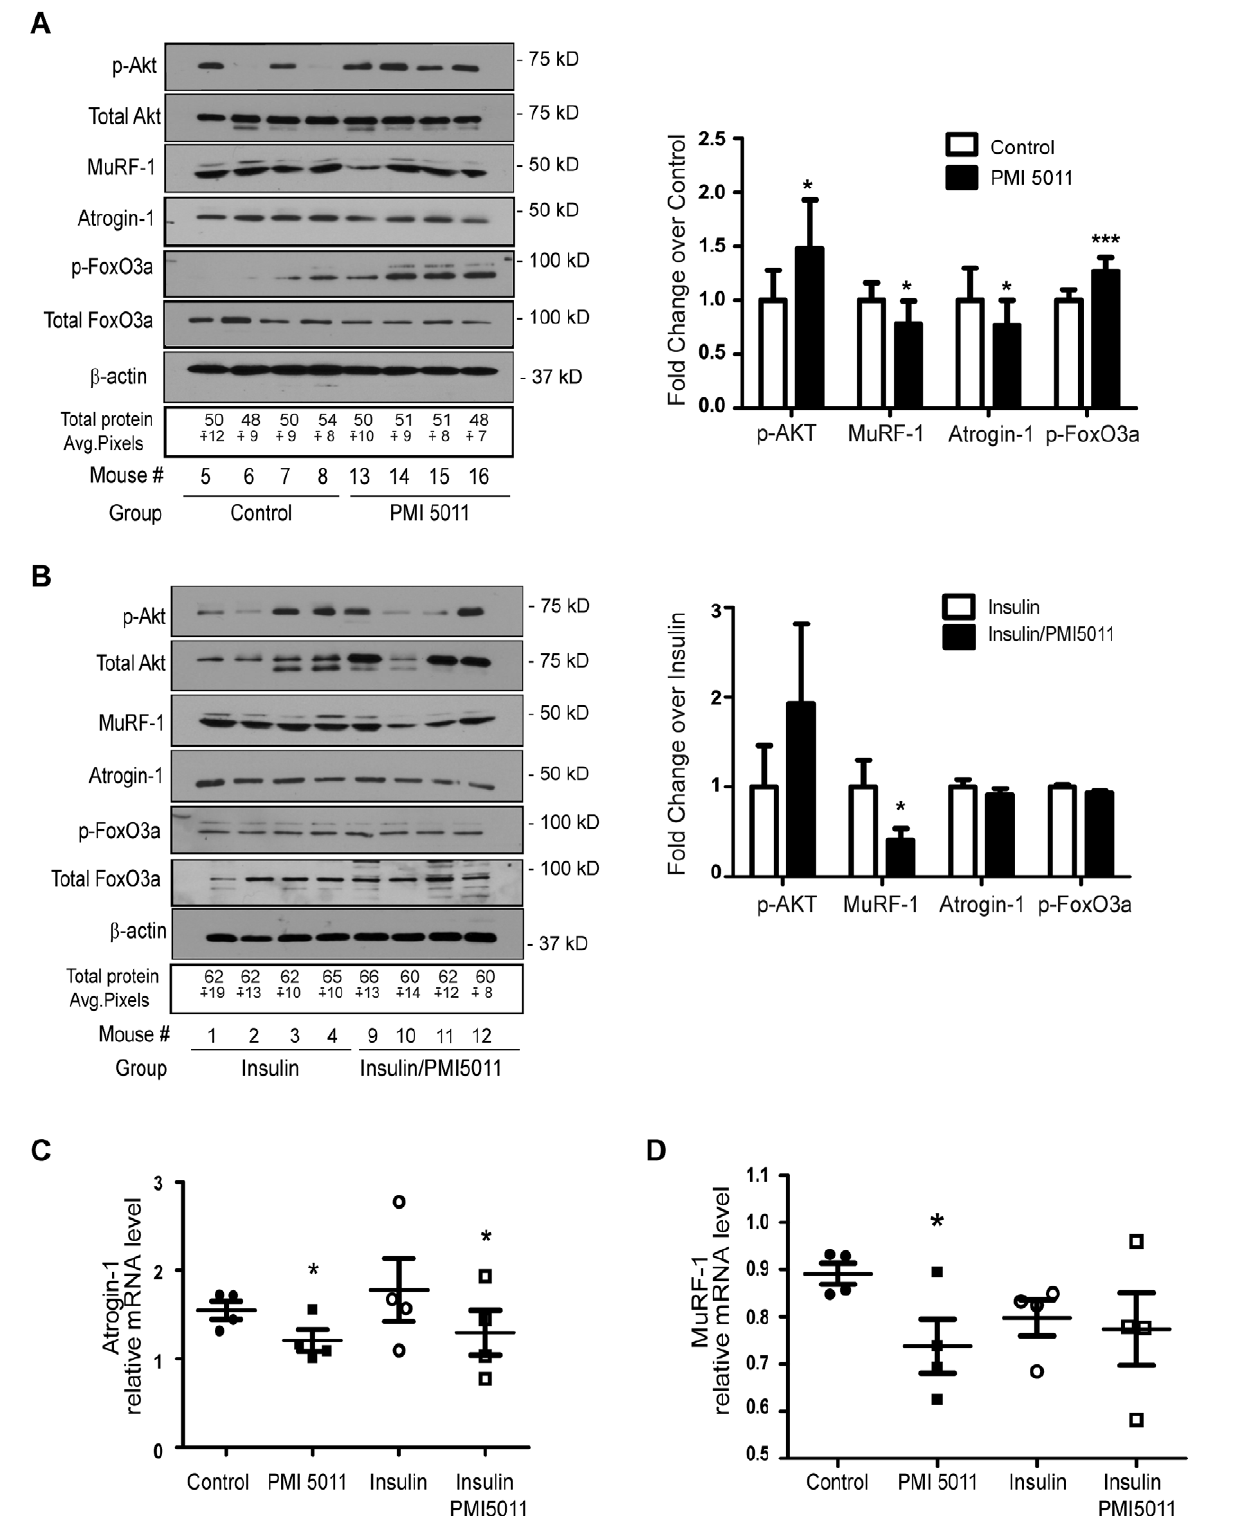
Figure 7. PMI5011 regulates Atrogin-1 and MuRF-1 gene and protein expression in skeletal muscle. (A, B) Skeletal muscle from KK-Ay mice was processed for whole cells extracts and analyzed using SDS-PAGE followed by western blot analysis of phospho-Akt, total Akt, MuRF-1, Atrogin-1, phospho-FoxO3a and total FoxO3a. b -actin and quantitation of the total protein loaded via MemCode staining are included as loading controls. Fold change for phospho-Akt/total Akt, phospho-FoxO3a/total FoxO3a, MuRF-1/total protein and Atrogin-1/total protein is reported for PMI5011 relative to control (A) or PMI5011 combined with insulin relative to insulin alone (B). (C, D) Atrogin-1 and MuRF-1 gene expression was determined using realtime RT-PCR. Results are reported as the mean 2 / + standard deviation (N=4/group). * p , 0.05, *** p , 0.001. Significance is reported relative to control in (C, D). doi:10.1371/journal.pone.0057112.g007 PLOS ONE |